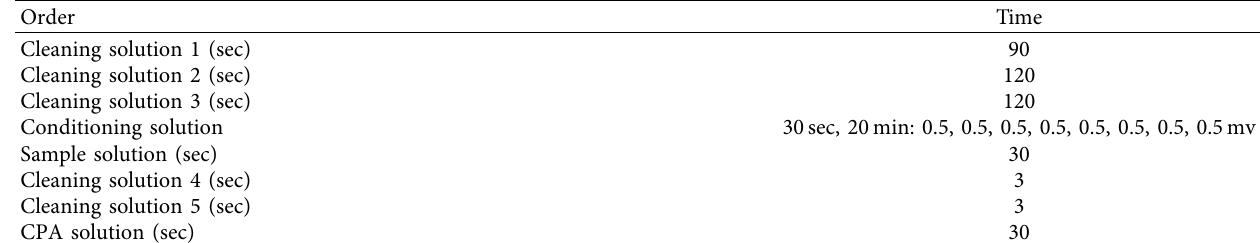
Table 3: Electronic tongue taste determination conditions.